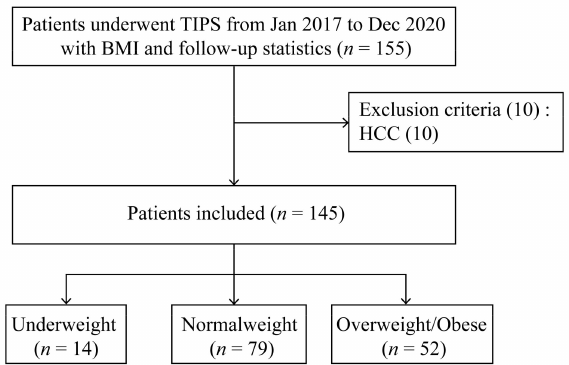
Figure 1. Patient flow chart. BMI, body mass index; HCC, hepatocellular carcinoma; TIPS, transjugu- lar intrahepatic portosystemic